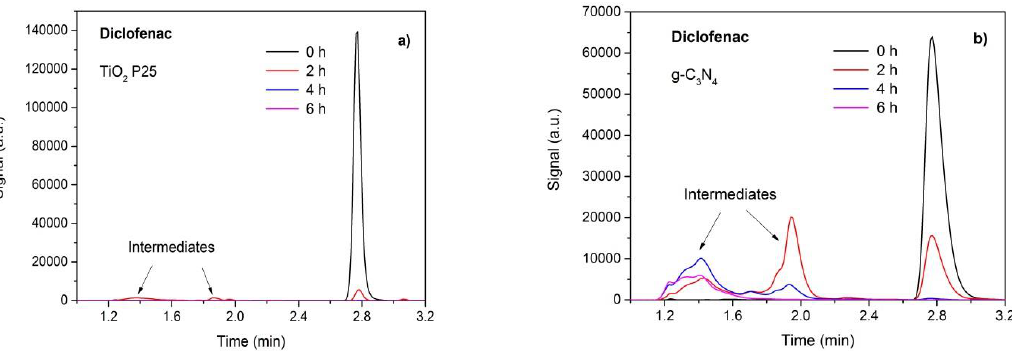
Figure 8. Photocatalytic degradation of diclofenac using TiO 2 P25 under UV ( a ) and exfoliated g-C 3 N 4 ( b ) under VIS irradiation.